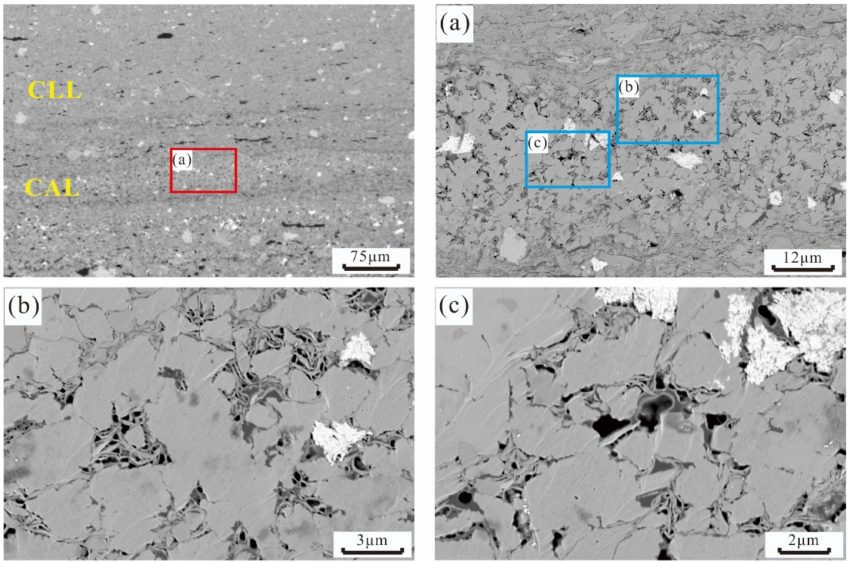
Figure 7. SEM images of CAL from Well G108-8 at 3209.43 m. ( a ) Magnification of CAL; ( b ) in- tercrystalline pores of clay minerals in CAL; ( c ) organic pores in CAL. CLL: clay laminae; CAL: carbonate laminae.